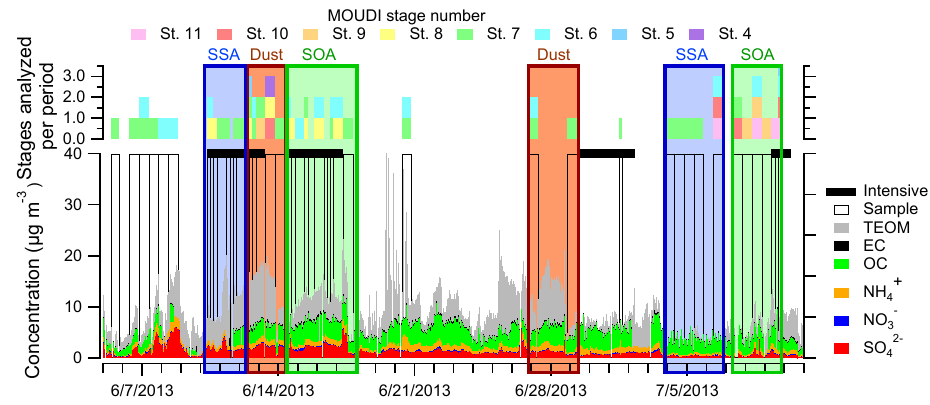
Figure 1. SEARCH filter sample data for Centreville, AL, during SOAS with purple boxes overlaid for time periods in which CCSEM was run and the corresponding MOUDI stages that were analyzed. SOA-rich periods denoted with green boxes (14–17 June and 7–11 July 2013) were studied by Xiong et al. (2015), Pye et al. (2015), Xu et al. (2015b), Hu et al. (2015), and Rattanavaraha et al. (2016); dust-rich periods marked with brown boxes (12–13 June and 26–28 June 2013) were identified by Allen et al. (2015); and SSA-rich periods marked with blue boxes (10–11 June and 3–6 July 2013) were identified by Bondy et al. (2017b). Time periods without samples analyzed are due to sample damage and identification of mutually exclusive time periods. Based on periods identified in previous studies, only 29% of SOA-dominant periods, 40% of dust periods, and 51% of SSA periods were analyzed